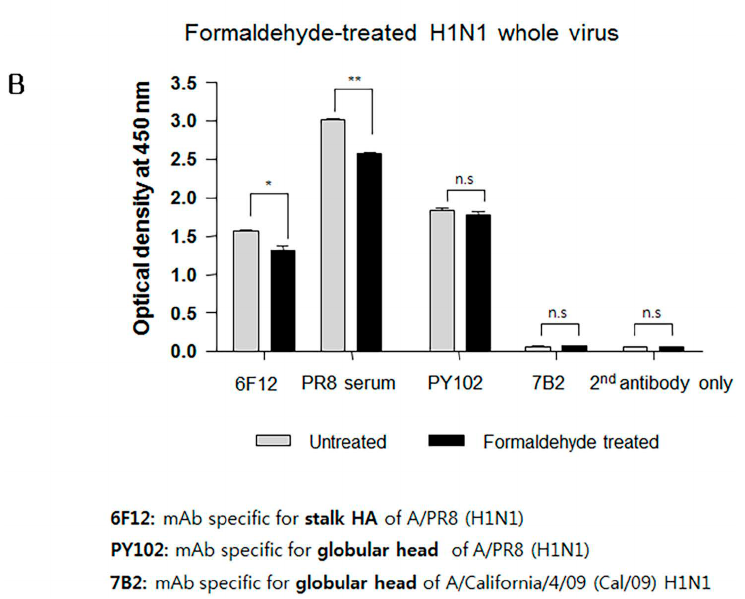
Figure 7. Formaldehyde treatment reduces the binding of a conformation-specific monoclonal antibody (mAb) to the HA stalk. ELISA were performed using mAb 6F12, mAb PY102, and mAb 7B2 that are specific for the PR8 HA stalk, globular head of PR8 virus, and globular head of A/California/4/09 (Cal/09) H1N1 virus, respectively. ELISA plates were coated with formaldehyde-treated or untreated chimeric protein (cH9/1) ( A ) or with formaldehyde-treated or untreated whole PR8 virus particles ( B ). Secondary (2nd) horseradish peroxidase (HRP)-conjugated Ab alone was included as the assay control. The data represent results from three independent ELISA with six wells per antigen in 96-well plates (* p < 0.01, ** p <